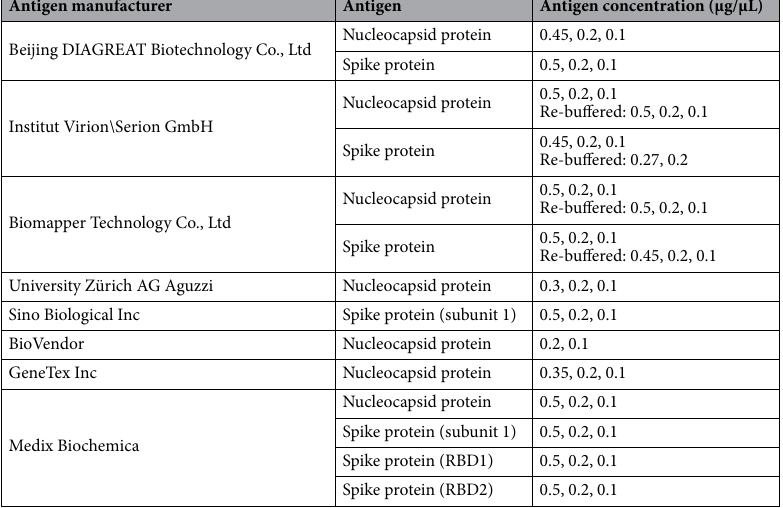
Table 2. SARS-CoV-2 Antigens, antigen manufacturer and concentrations spotted on the microarray chip .